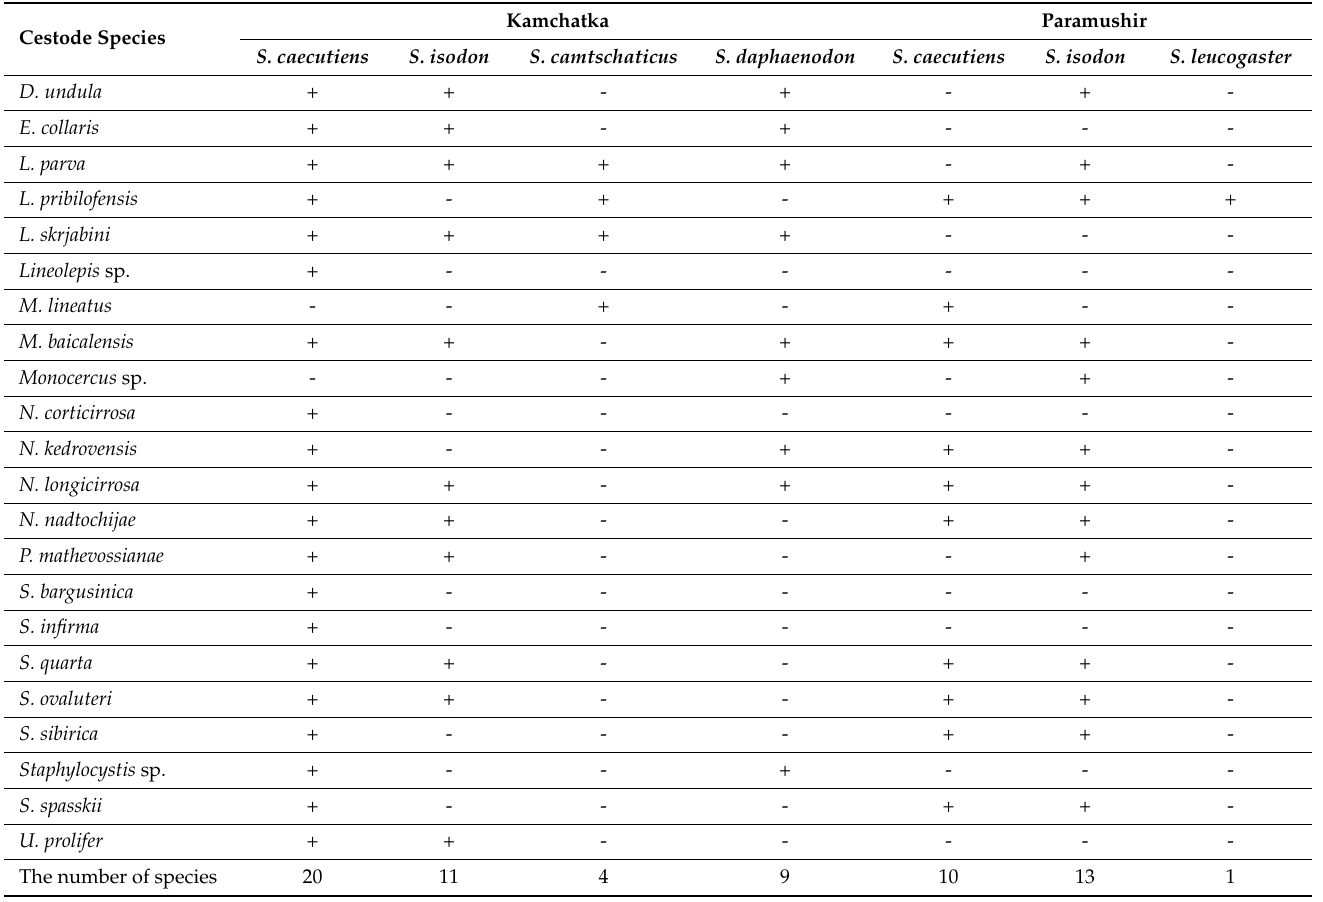
Table 2. Distribution of cestodes in different shrew species in Kamchatka and Paramushir